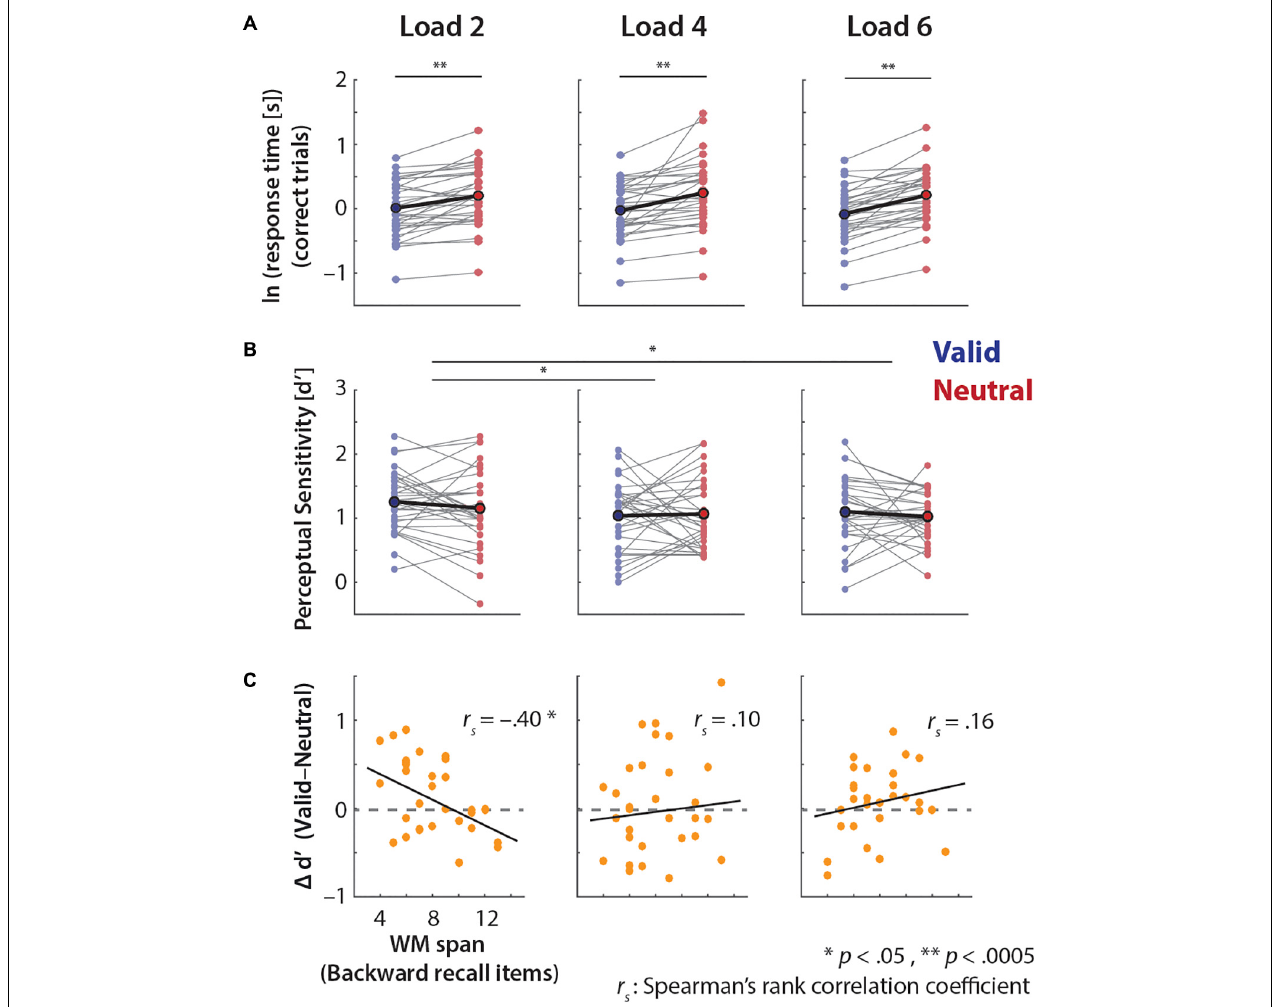
FIGURE 3 | Pitch-discrimination performances of the valid and neutral retro-cue trials in each memory load. (A) Log-transformed response time exhibits a consistent effect of retro-cue across memory loads. (B) Perceptual sensitivity d (cid:48) shows higher overall performance in the low load (Load 2) than higher loads (Loads 4 and 6). The illustration scheme is same as Figure 2 . (C) Correlations between individuals’ backward auditory digit span scores and the cue-related d (cid:48) differences ( d (cid:48) Valid – d (cid:48) Neutral ) in each memory load